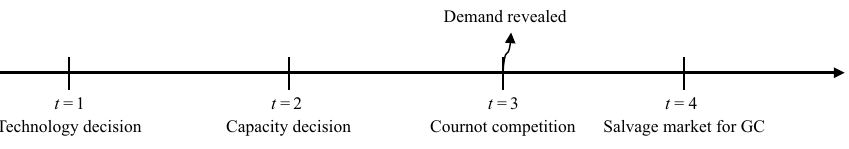
Fig. 1. Four-stage static